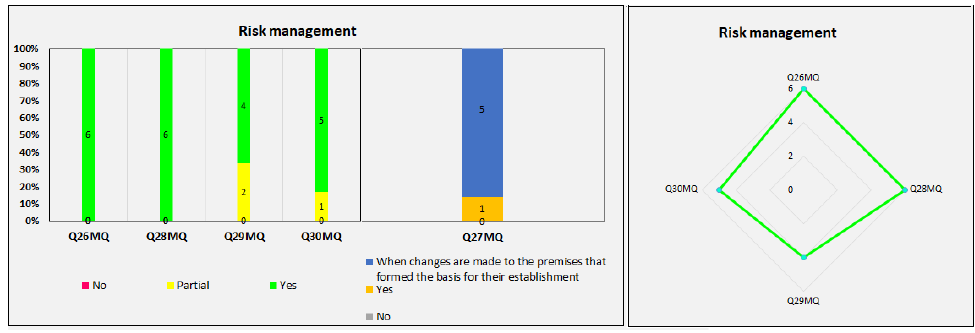
Figure 14. Answers regarding the risk management criteria.